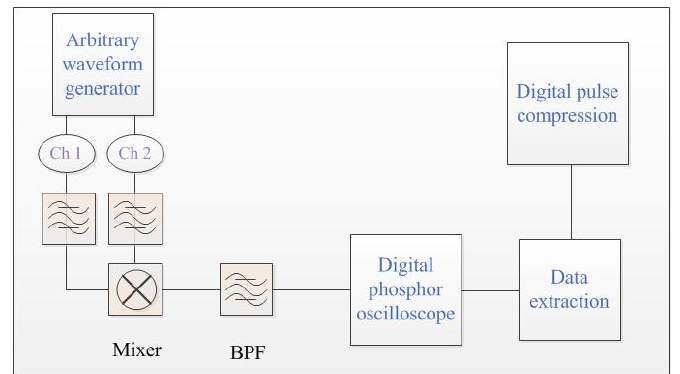
Figure 8. Experimental verification of the novel LPSA algorithm for pulse compression. Output IF chirp signals from the band-pass filter were first sampled and stored by a 2 G bandwidth DPO and then compressed by the classical time-domain pulse compression method and the LPSA algorithm in